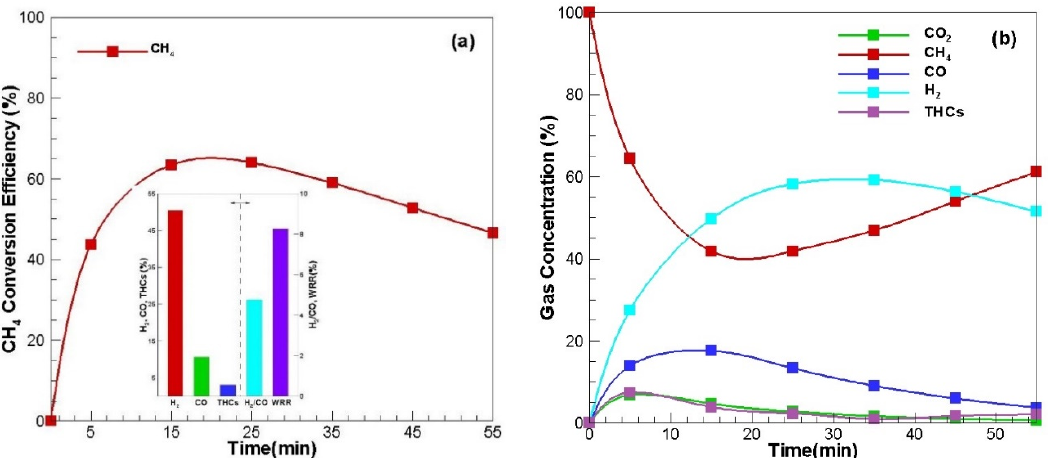
Figure 2. Characteristics of methane reforming. ( a ) CH 4 conversion efficiency, H 2 /CO ratio, weight reduction rate (WRR), product gas average concentration and ( b ) product gas concentration over time.